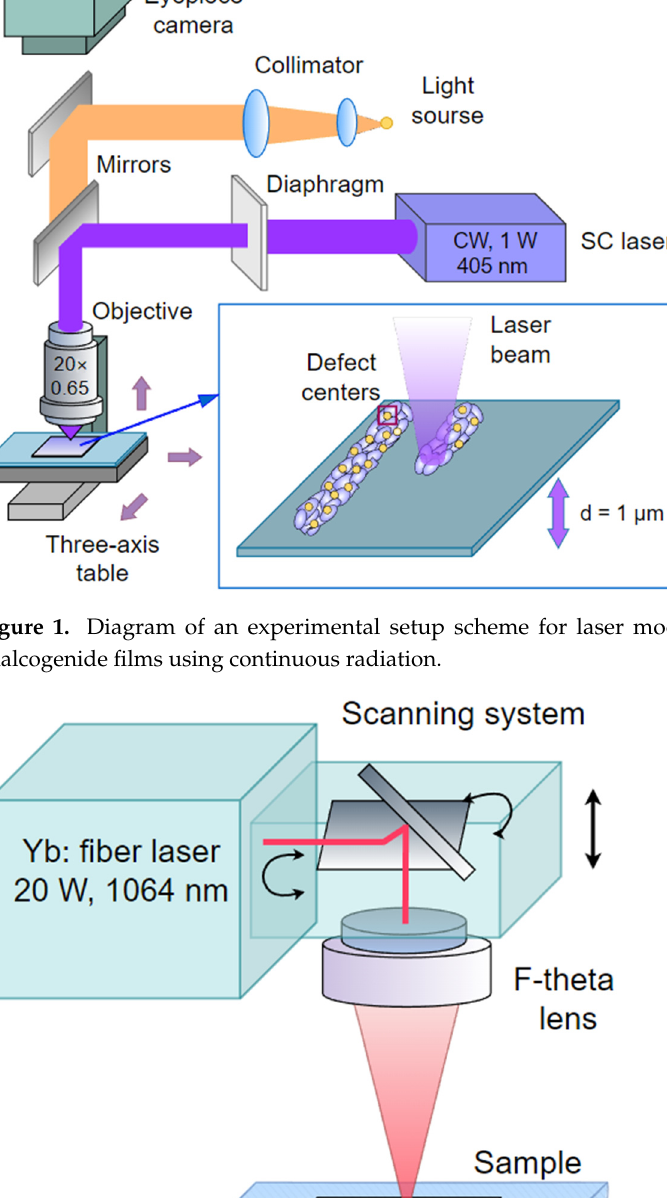
Figure 2. Scheme of the experimental setup for chalcogenide film structure laser modification using pulsed radiation.